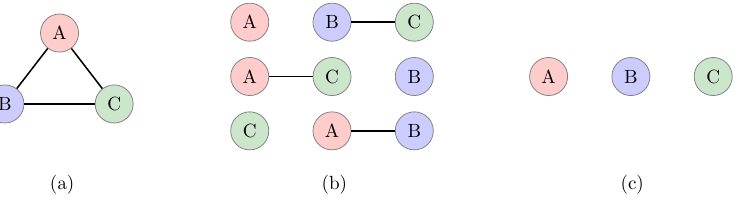
Figure 1. Tripartite entanglement classes depicting ( a ) fully entangled, ( b ) biseparable, and ( c ) fully separable